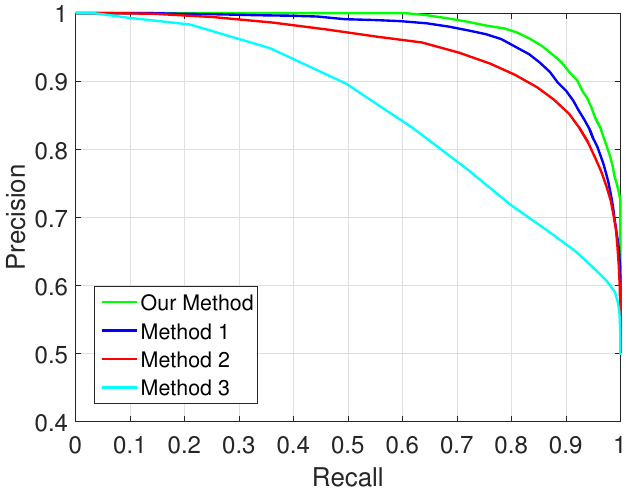
Figure 10. Precision-recall curves for the results of loop closure